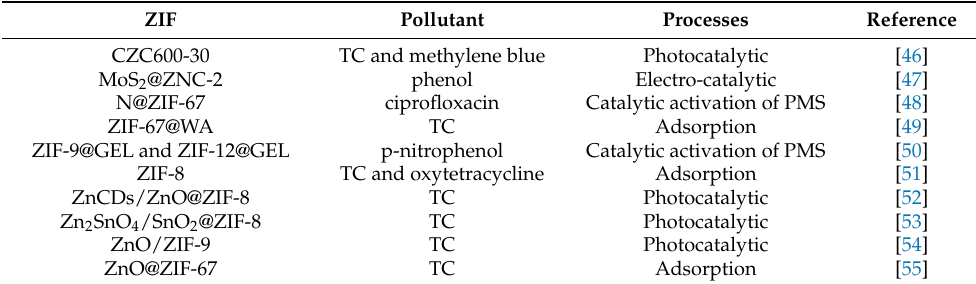
Table 2. Applications of ZIF–MOF in wastewater treatment.